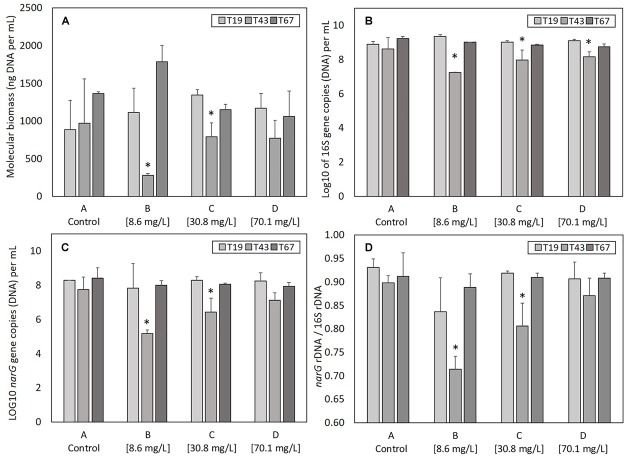
Parameters linked to bacterial abundance: (A) molecular biomass (genomic DNA concentration), (B) Log10 of 16S rRNA gene copies, (C) Log 10 of narG gene copies, and (D) ratio narG over 16S rRNA genes copies, at T19 (before nZVI addition) and T43/T67 (after nZVI addition). ∗ Corresponds to a significant difference (P < 0.05, Student’s t-test) between T19 and T43 values, corresponding to a significant impact of nZVI addition.